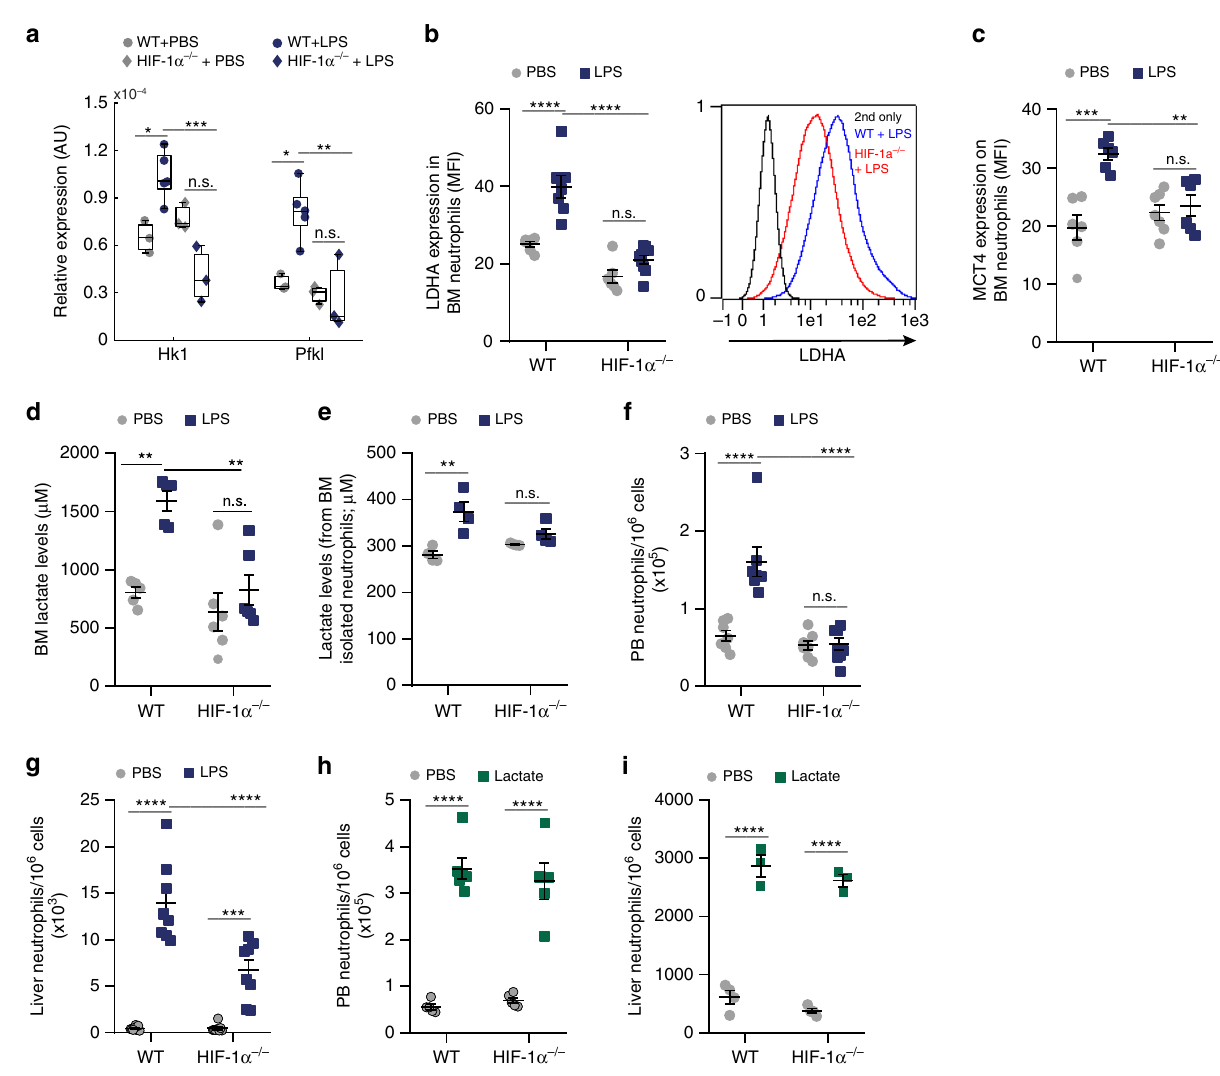
Fig. 4 HIF-1 α mediates lactate release and in fl ammatory neutrophil mobilization. a Gene expression of glycolytic enzymes in sorted BM neutrophils following LPS treatment (WT; n = 3, PBS; n = 5, LPS; HIF-1 α − / − , n = 3). On each box, the bottom, middle and the top edges indicate the 25th, 50th, and 75th percentiles, respectively. The whiskers extend to the most extreme data points. b Quantitative analysis and representative fl ow cytometry